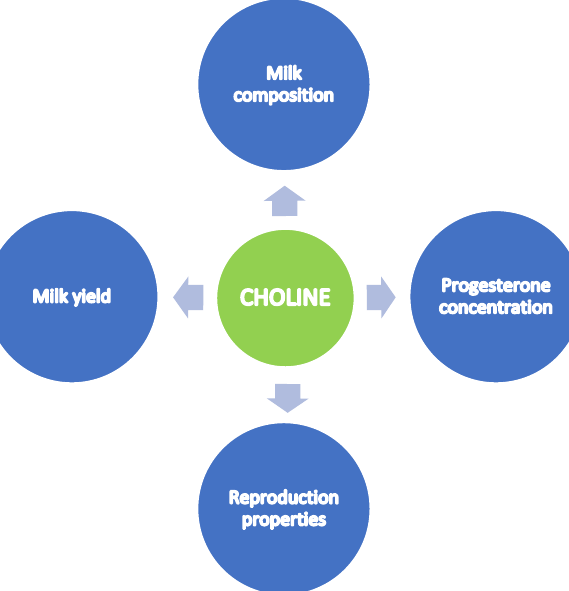
Figure 5. Positive effect of choline supplementation .